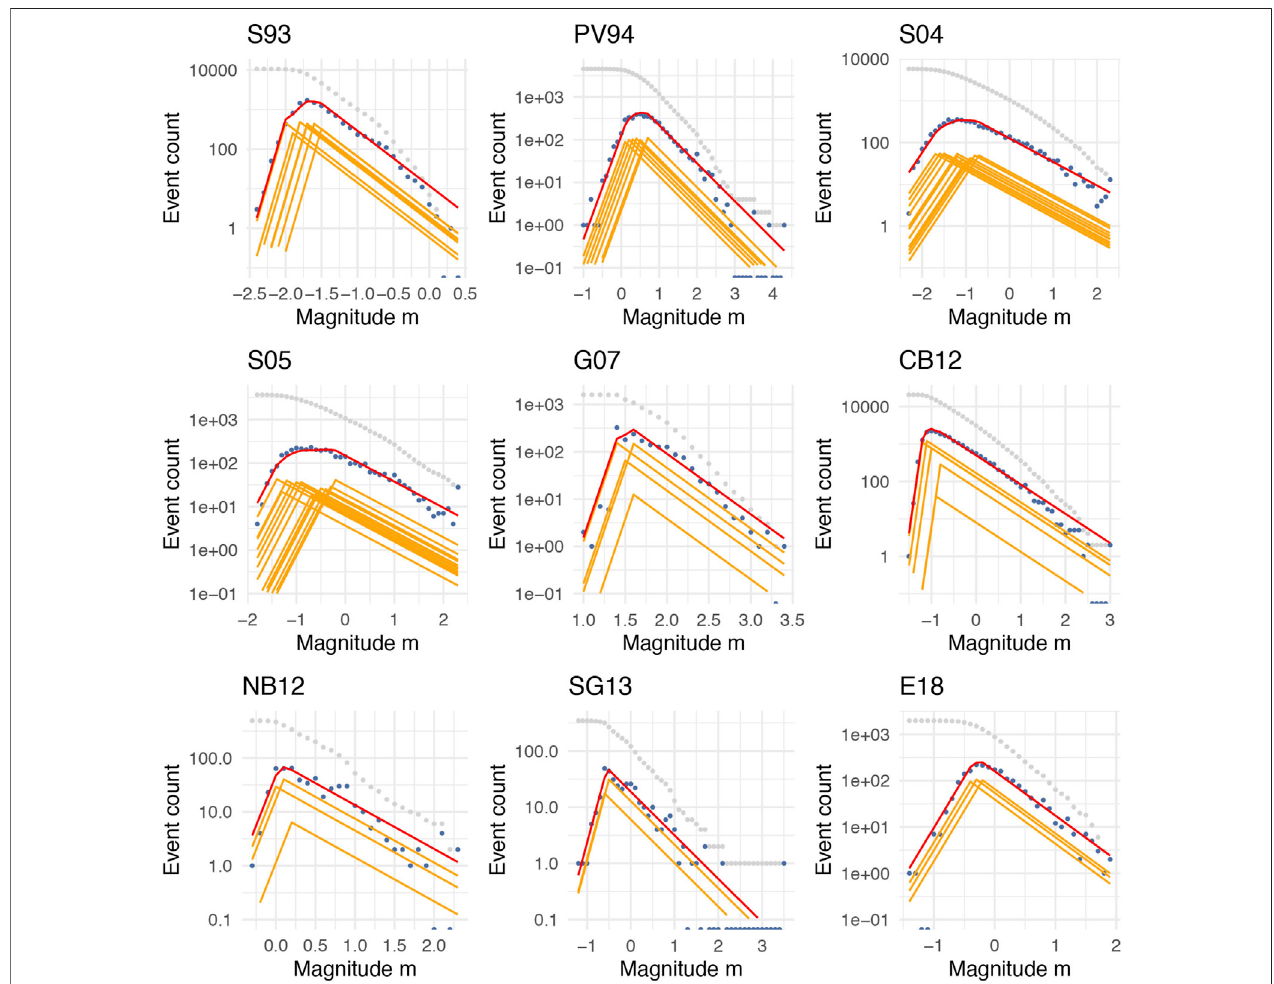
FIGURE3| Non-cumulativeMFD(inblue)of9undergroundstimulationsforwhichanAsymmetricLaplaceMixtureModel(ALMM) fi tisavailable, showninred,with the mixture components shown in orange. See Table 2 for some values.